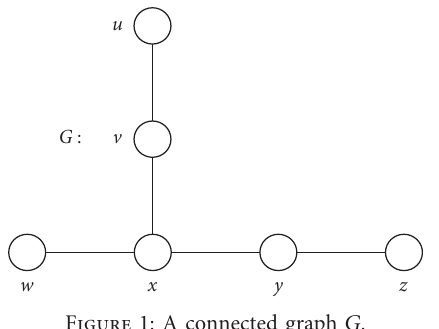
Figure 1: A connected graph G